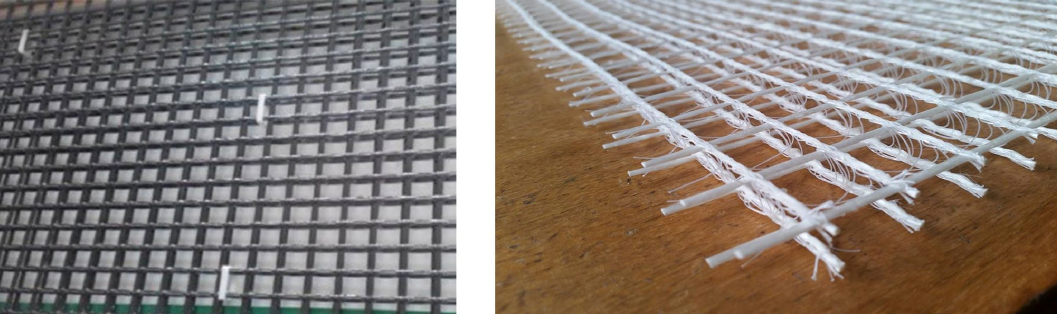
Figure 2. 2D carbon and 3D glass textiles.